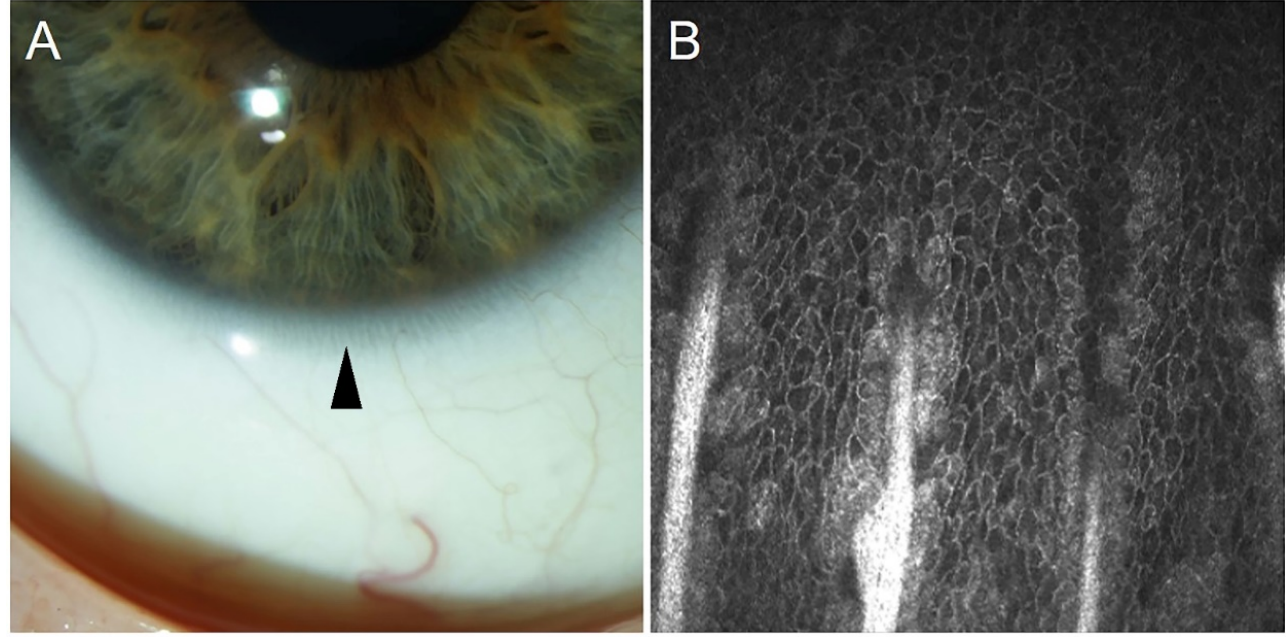
Figure 2. The limbal palisades of Vogt taken by slit lamp (arrowhead, ( A )) and by in vivo confocal microscopy (Heidelberg Engineering GmbH, Heidelberg, ( B )).